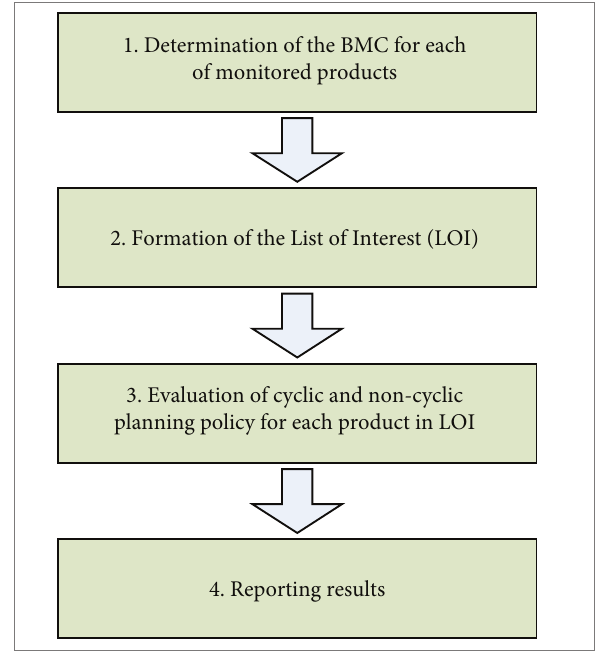
Fig. 3. Decision Analysis Agent functioning